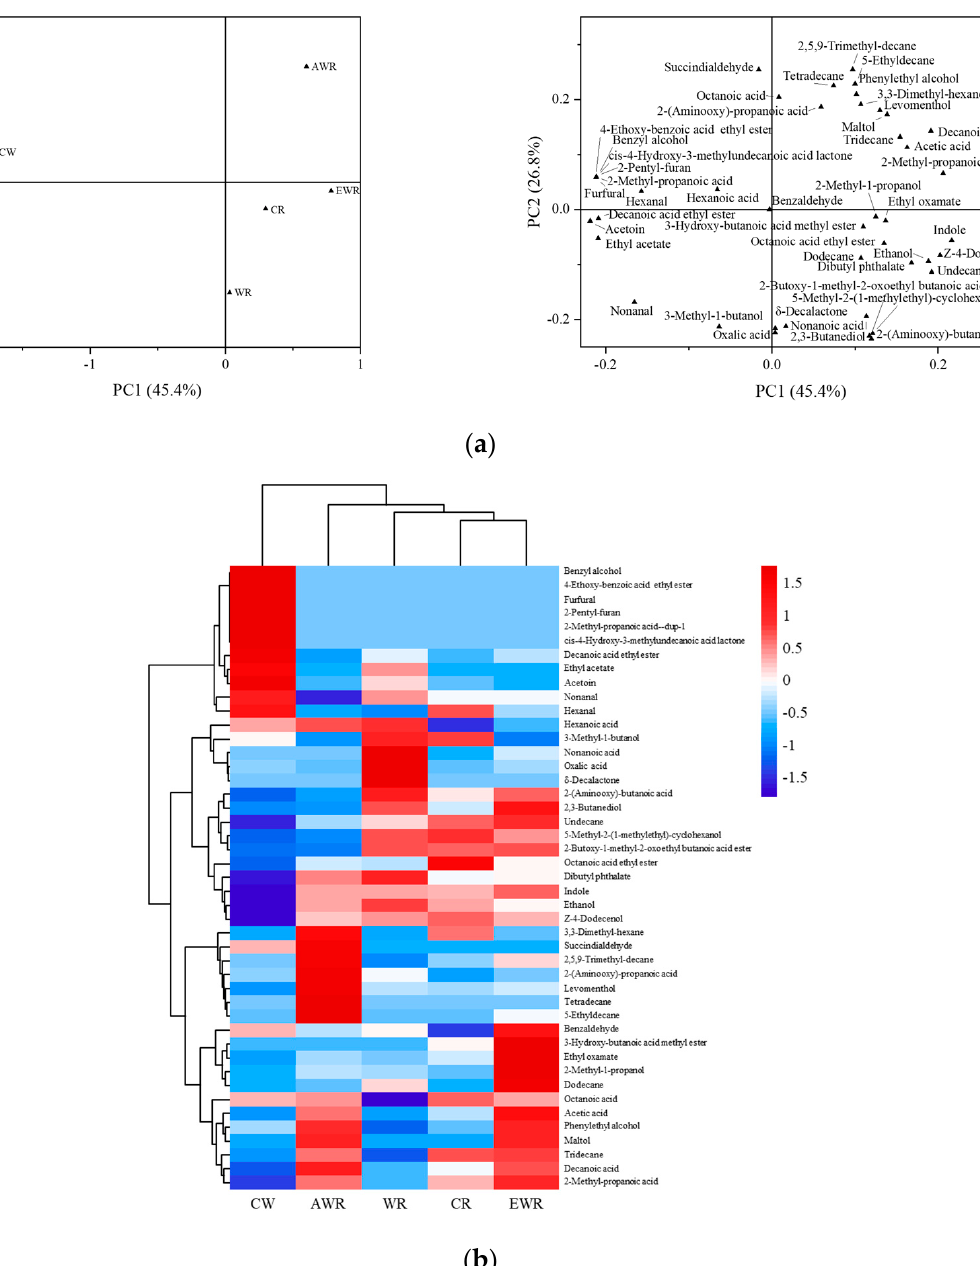
Figure 3. ( a ) Principal component analysis of volatile aroma compounds of wheat–red bean sour- dough bread. ( b ) Effect of in situ-formed EPS on volatile compounds of red bean sourdough bread. The color code indicates relative abundance, ranging from blue (low abundance) to white to red (high abundance).